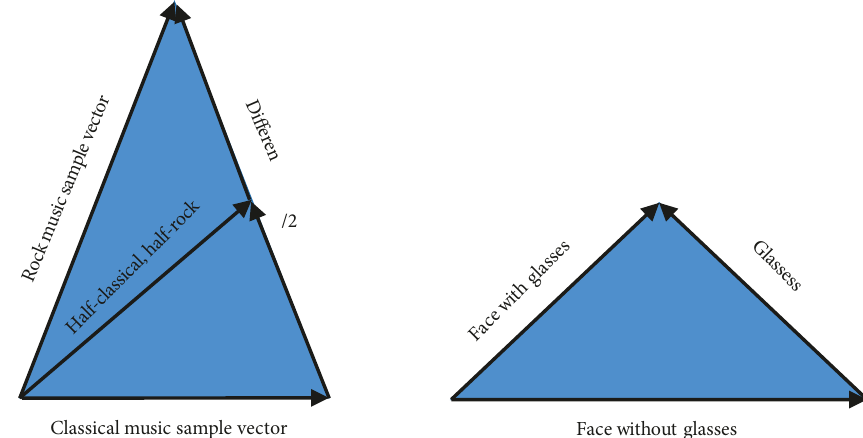
Figure 3: Multimedia assisted English teaching coding.